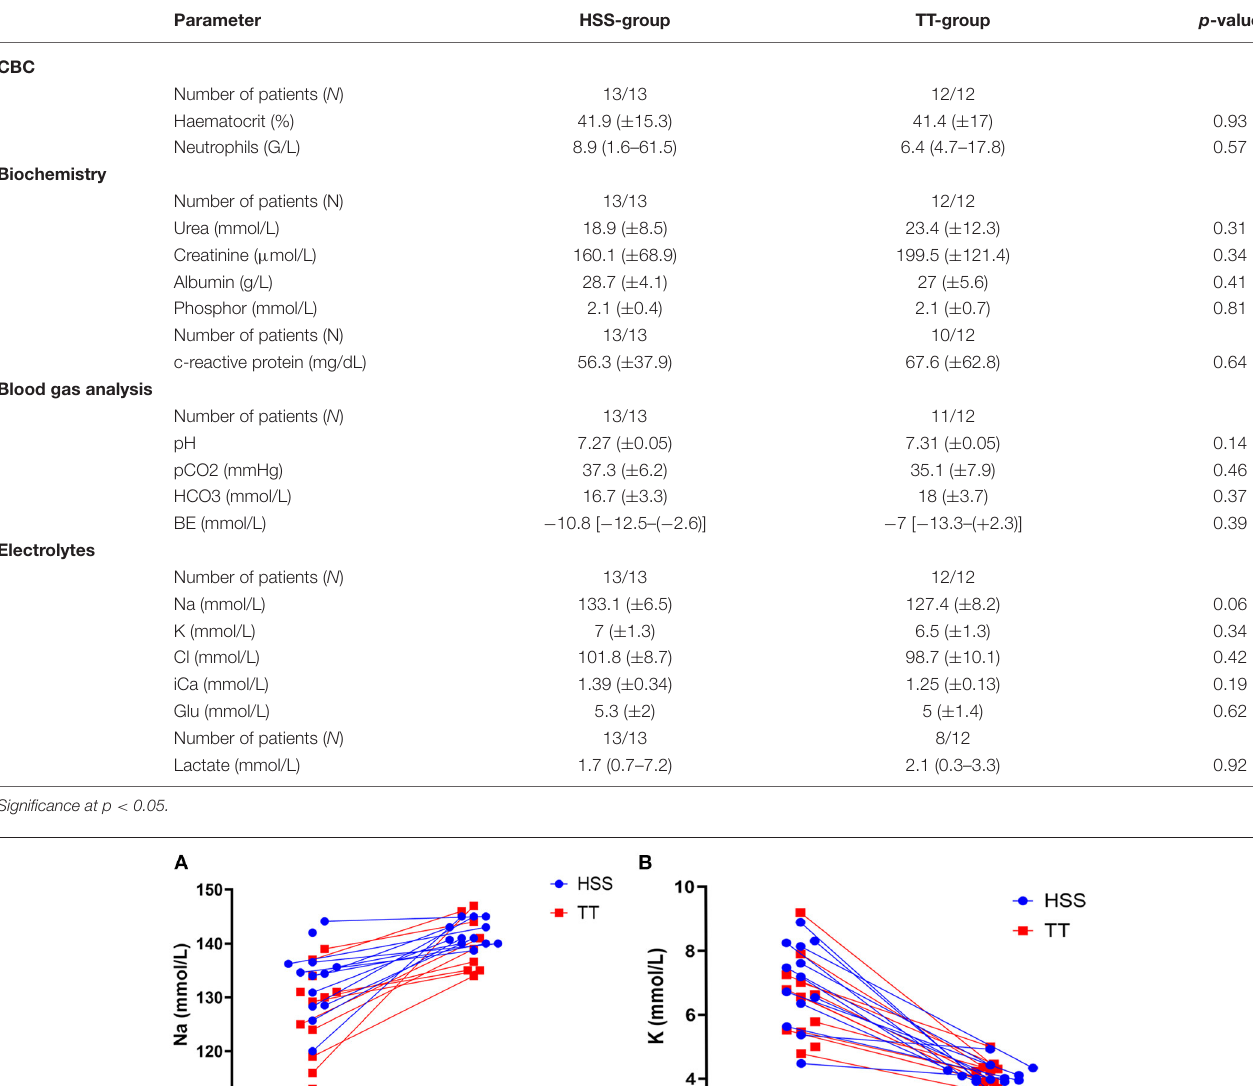
TABLE 2 | Comparison of the baseline clinicopathological variables including electrolytes and blood gas analyses values between dogs treated with hydrocortisone CRI (HSS group; n = 13) and dogs treated with prednisolone/dexamethasone (TT group; n = 12).